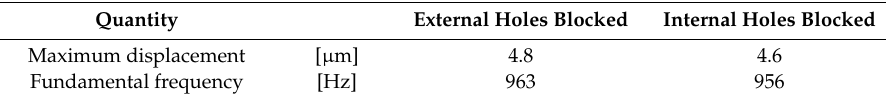
Figure 6. Static deformations: ( a ) External holes blocked and ( b ) Internal holes blocked. Displacements are given in millimeters. Table 6. FE static and modal analysis